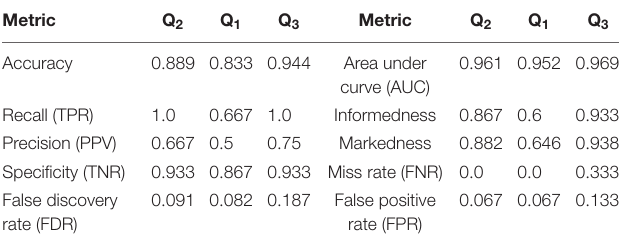
TABLE 3 | Comparative performance metrics for ConcNet 2 computed from the MCCV tests.